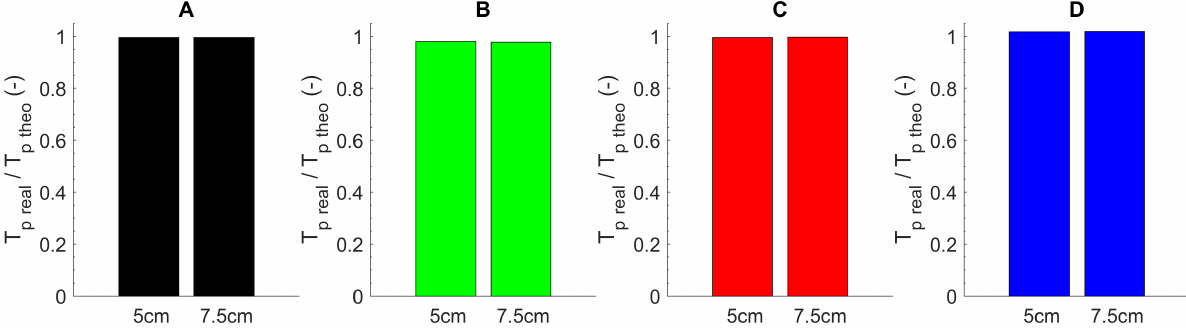
Figure 7. Ratio of realised ( T p 7.5 cm sea-sate for facilities ( A – D ).